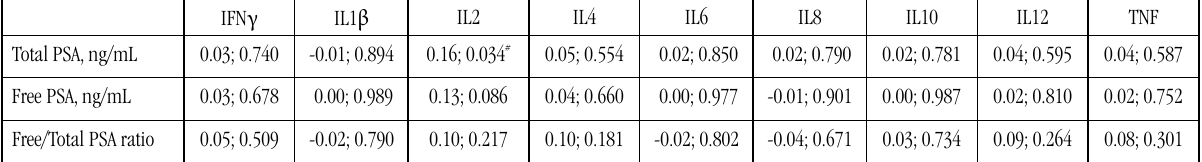
TABLE 2 - Correlation analyses of raw serum forms of the prostate-specific antigen (total and free) and their ratio across levels of the inflammatory mediators investigated in the162 older men at